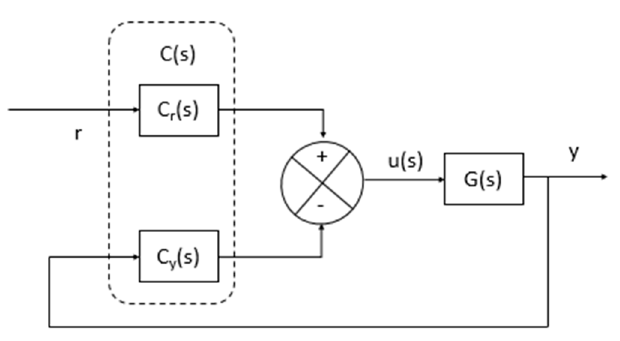
Figure 5. A block diagram of actual and derived (using SI toolbox) elbow revolute joint system.